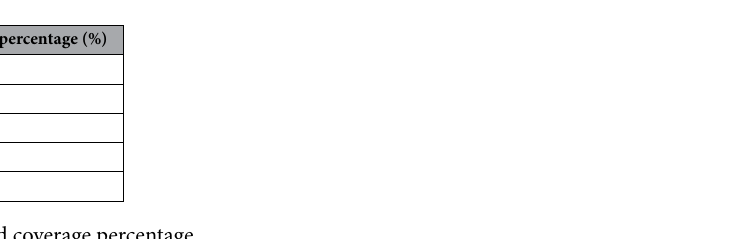
Table 3. Dye indicator and coverage